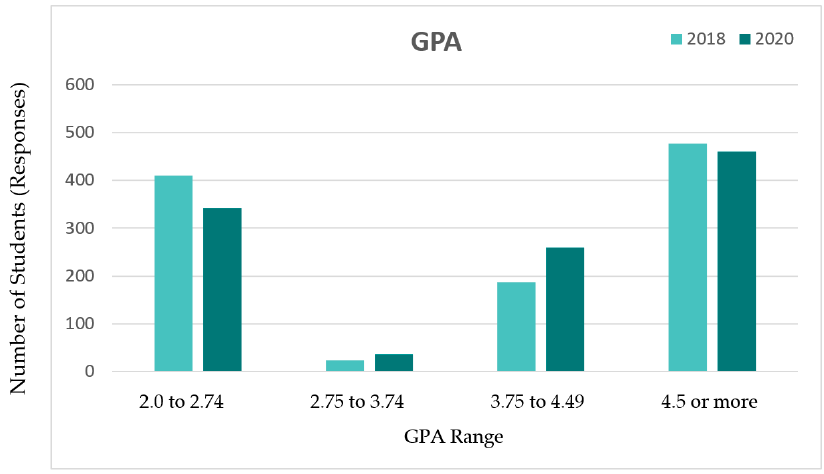
Figure 3. Distribution of student numbers by approved academic hours between 2018 and 2020 sur- vey periods.